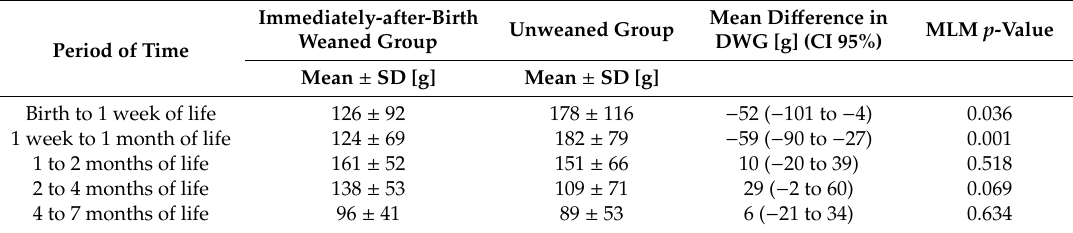
Table 2. Daily weight gain (DWG) of kids [g] shown as mixed linear model-estimated means and standard deviation (SD) during the study